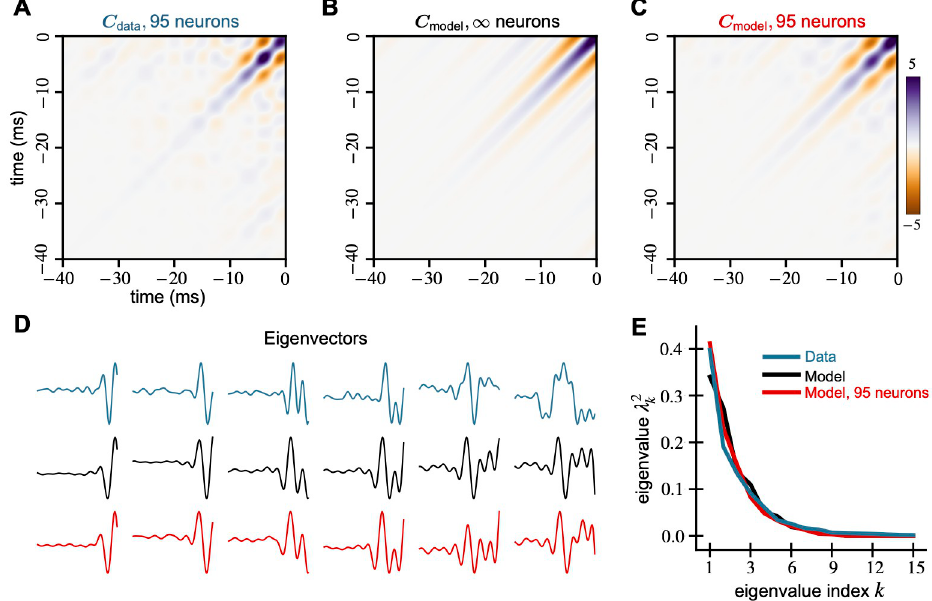
Fig 3. Spectral properties of mechanosensory RFs and our model are similar. We compare the covariance matrices generated from (A) receptive fields of 95 mechanosensors from [14], (B) the model Eq (8), and (C) 95 random samples from the same model. All covariance matrices show a tri-diagonal structure that decays away from the origin. (D) The first five principal components of all three covariance matrices are similar and explain 90% of the variance in the RF data. (E) The leading eigenvalue spectra of the data and models show similar